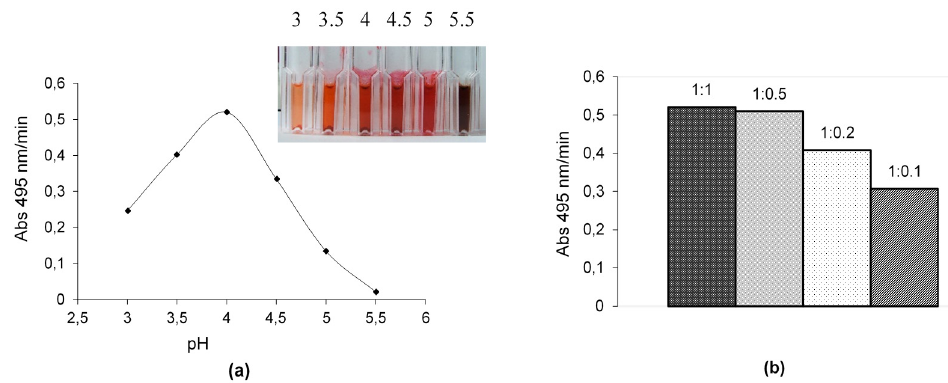
Figure 2. Influence of the pH value ( a ) and the molar ratio of substrates A and B2 (1:1, 1:0.5, 1:0.2, 1:0.1—A:B2 molar ratio) ( b ) on the rate of phenazine AB2 synthesis mediated by LAC.